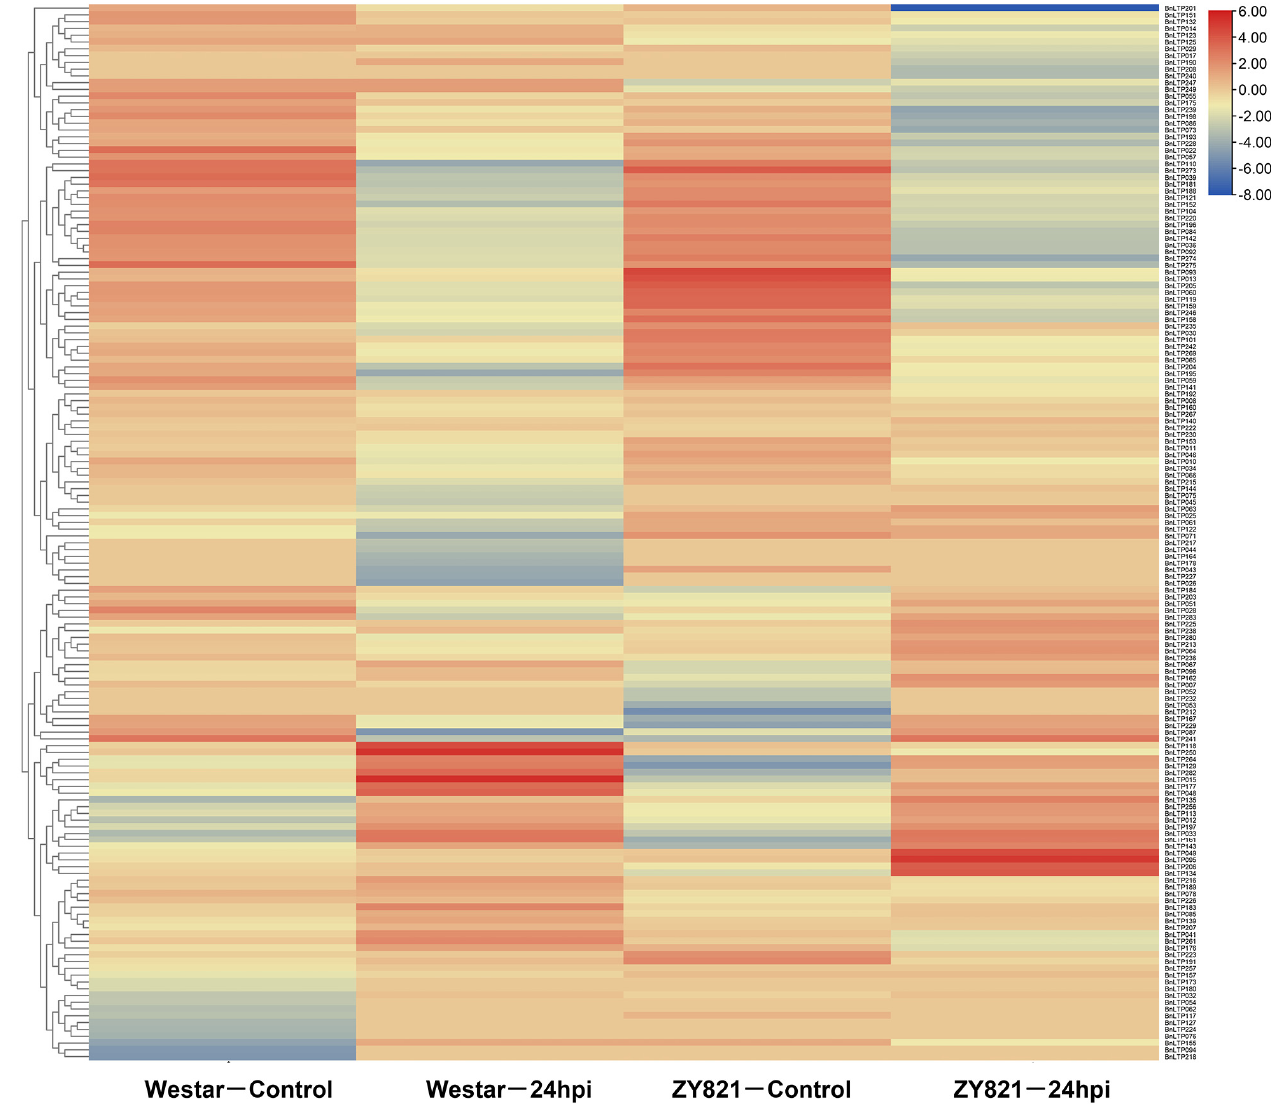
Figure 5. Expression patterns of BnLTP family genes in the leaves of susceptible (Westar) and tolerant (ZY821) genotypes of rapeseed infected with S. sclerotiorum at 24 h post-inoculation (24 hpi).